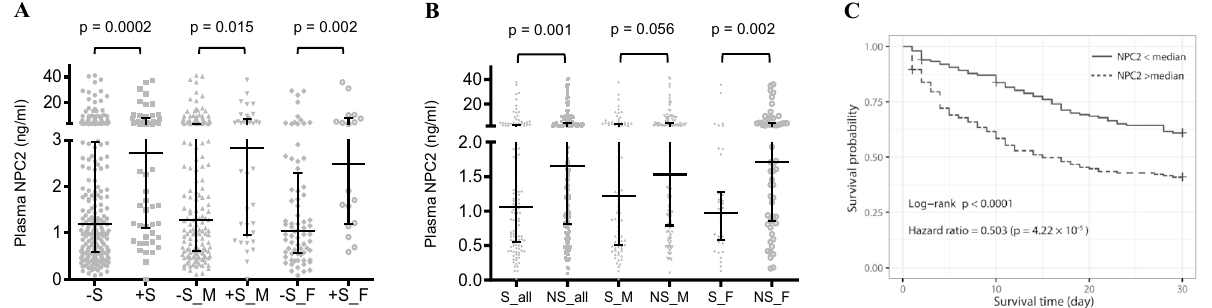
Figure 4. The association of plasma Niemann–Pick disease type C2 protein (NPC2) with sepsis prognosis The concentration of plasma NPC2 in sepsis patients was determined by ELISA. ( A ) Comparison (Mann–Whitney U test) of NPC2 concentrations in sepsis patients that subsequently did or did not develop septic shock. − S, no septic shock, n = 233; + S, septic shock, n = 54; − S_M: male no septic shock, n = 161; + S_M: male septic shock, n = 36; − S_F: female no septic shock, n = 72; + S_F: female septic shock, n = 18. Mann–Whitney U test was used. ( B ) Comparison (Mann–Whitney U test) of plasma NPC2 concentrations in sepsis patients that survived (S) or did not survive (NS) within 30 days after sepsis diagnosis. S_all: all survivors, n = 123; NS_all, all nonsurvivors, n = 188; S_M: male survivors, n = 84; NS_M: male nonsurvivors, n = 133; S_F: female survivors, n = 39; NS_F: female nonsurvivors, n = 55. ( C ) Sepsis patients were separated into high (> median) and low (< median) plasma NPC2 groups. The Kaplan–Meier survival curves of both groups were compared using the log-rank method. NPC2 concentration-associated hazard ratios of these two groups were estimated by Cox regression analysis. All p values reflect a two-tailed